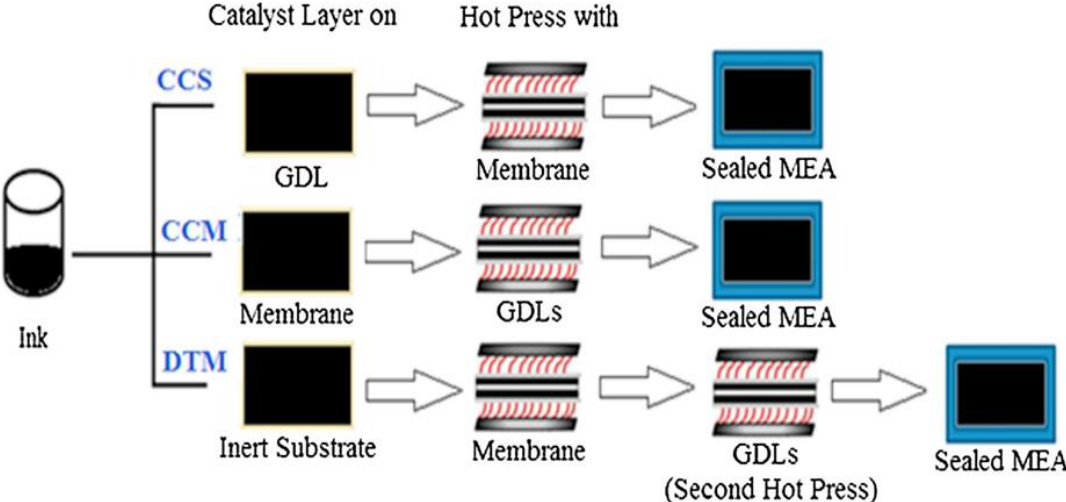
Figure 11. Methods of MEA fabrication: CCS (catalyst-coated substrate), CCM (catalyst-coated membrane), and DTM (decal transfer method) [183] (license no. 5172570377598).